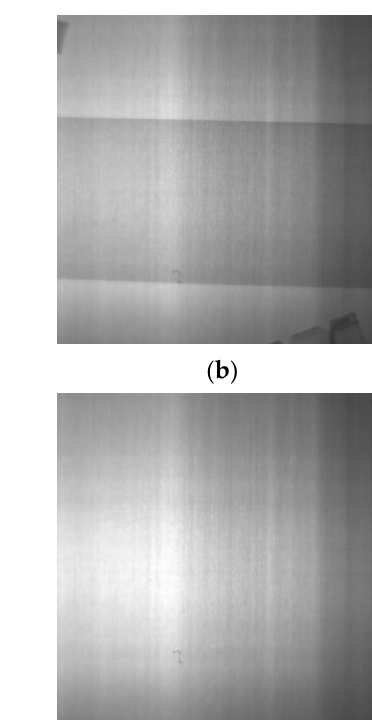
Figure 2. 3D CAD drawing of the CNRF.